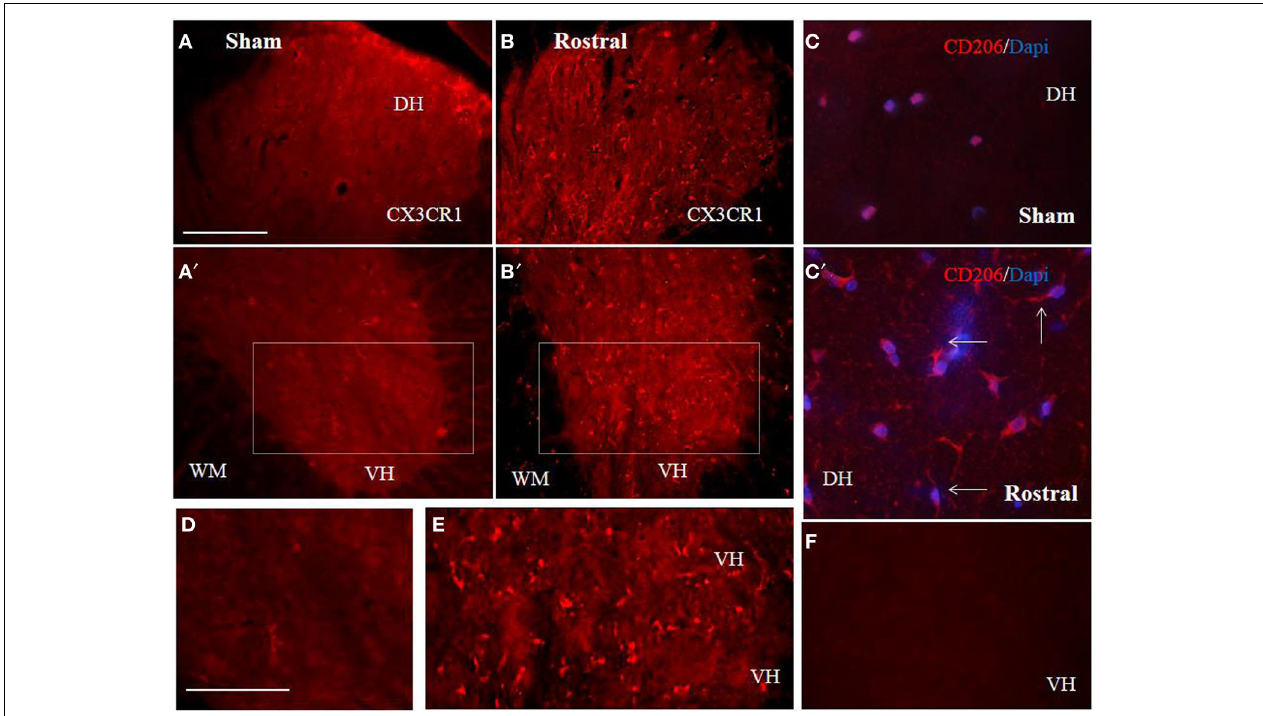
FIGURE 7 | Comparison of CX3CR1 expression in representative cross sections of thoracic spinal cord from sham and SCI rats at the rostral and caudal segmental levels. CX3CR1 showed low expression pattern in sham, throughout GM (dorso-ventral axis) and WM (A,A’,D) , while injury stimulated CX3CR1 up-regulation (B–E) , particularly at rostral segments (B,B’,E) . Note, higher magnification of homogenous-membranous pattern of CX3CR1 in sham (D) , from